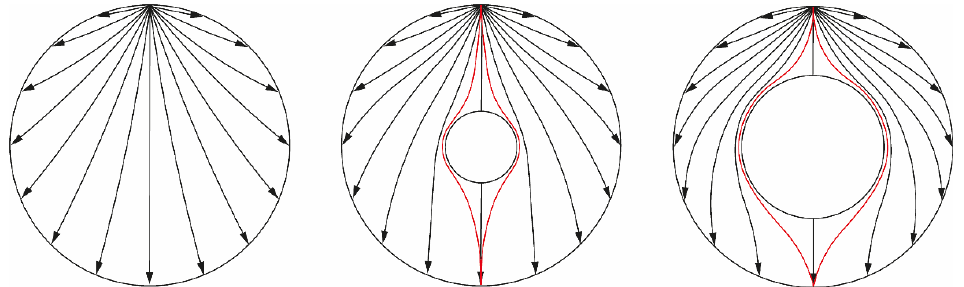
Figure 2. Estimated electric field lines inside the separator pipeline without an insulating core ( left ), with a small core ( middle ) and with a large core ( right ). The excited electrode (source) is always the top one. The black lines correspond to electric field lines reaching each sink electrode, since they are all at a lower potential than the source (grounded together). Additional electric field lines arriving at the electrode opposite to the source are presented in red.